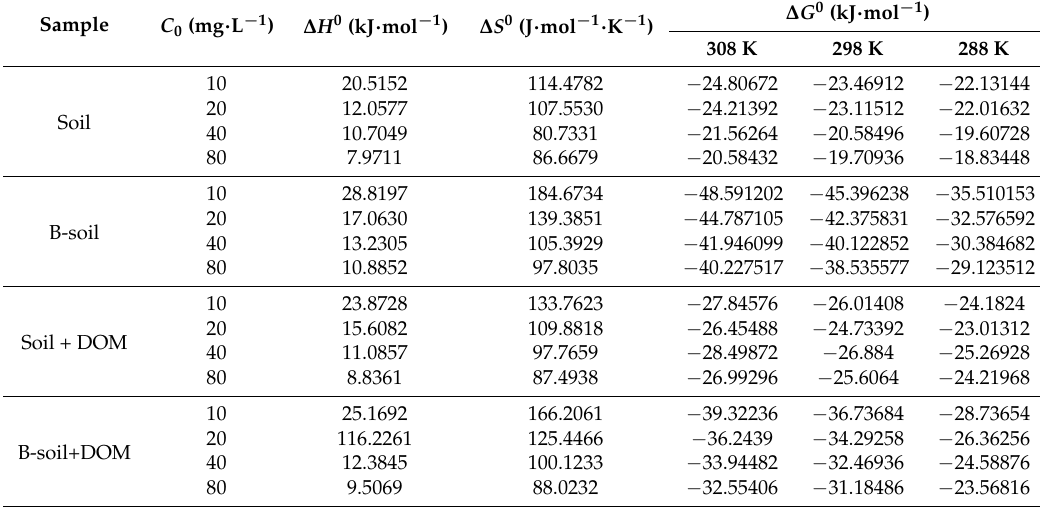
Table 3. Thermodynamic parameters for adsorption of BPs on the samples.